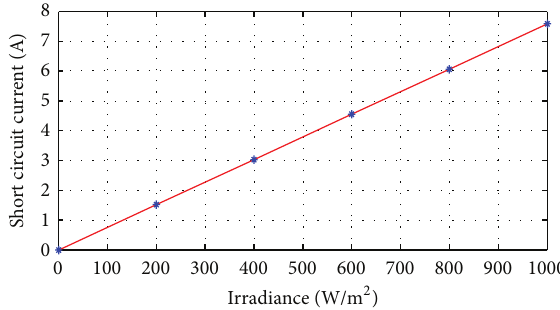
Figure 7: Variation of the open circuit voltage according to the temperature.